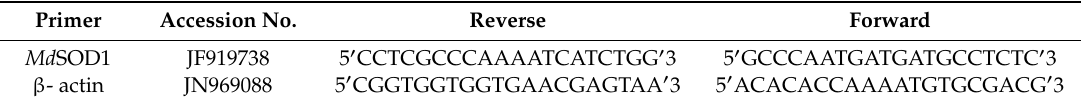
Table 1. Sequences of the primers used in the